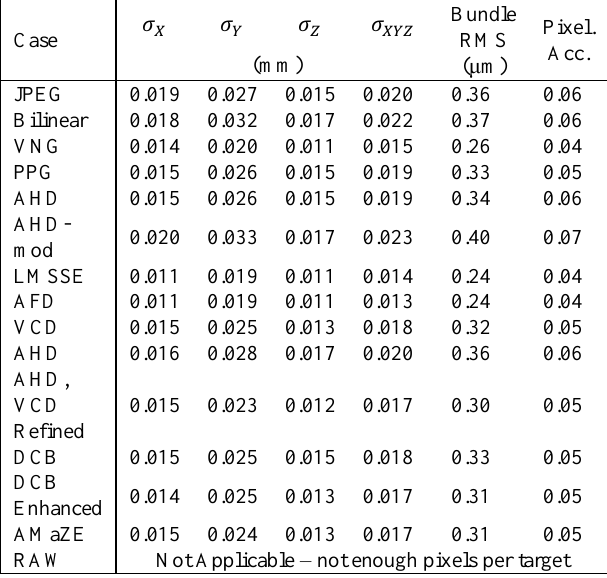
Table 4. Estimates of the mean positional standard errors for Blue